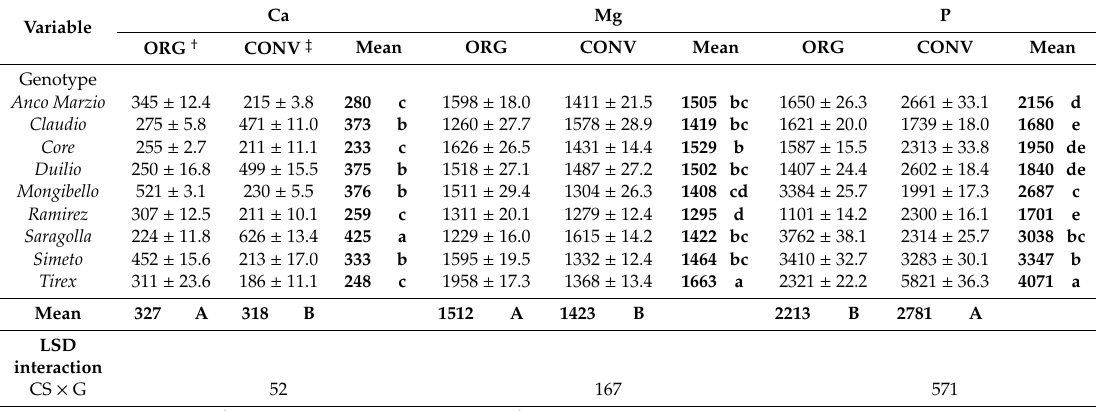
† ORG: organic cropping system; ‡ CONV: conventional cropping